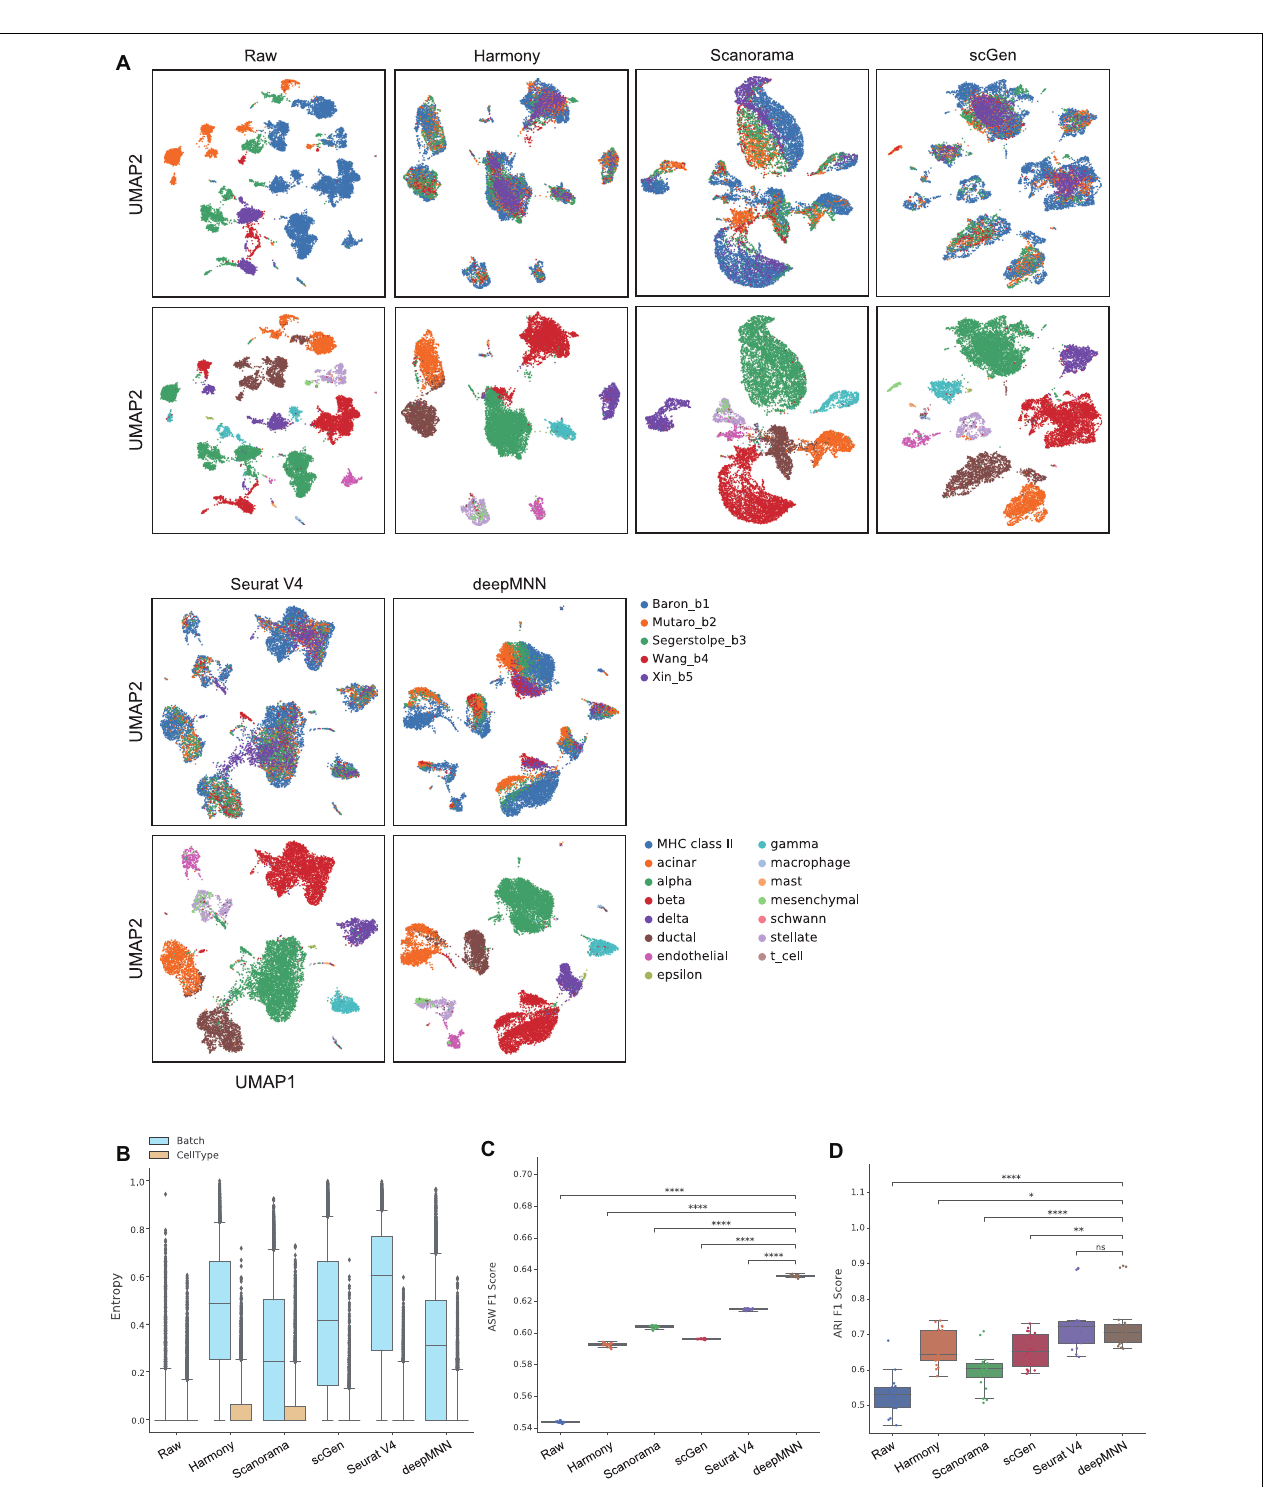
FIGURE 5 | Comparison of batch effect correction methods for the pancreas datasets with five batches. (A) Qualitative evaluation of the raw data, Harmony, Scanorama, scGen, Seurat V4, and deepMNN using UMAP. The cells were colored by batches on the top row and colored by cell type on the bottom row. (B) The batch and cell type entropies resulting from the batch correction methods. The plots show the median (line within box), 25th and 75th percentiles (box), 5th and 95th percentiles (whiskers), and outliers (diamond points). (C) The ASW F1 score resulting from different batch correction methods. (D) The ARI F1 scores resulting from different batch correction methods. ∗ 0.01 < p ≤ 0.05, ∗∗ 0.001 < p ≤ 0.01, ∗∗∗∗ p ≤